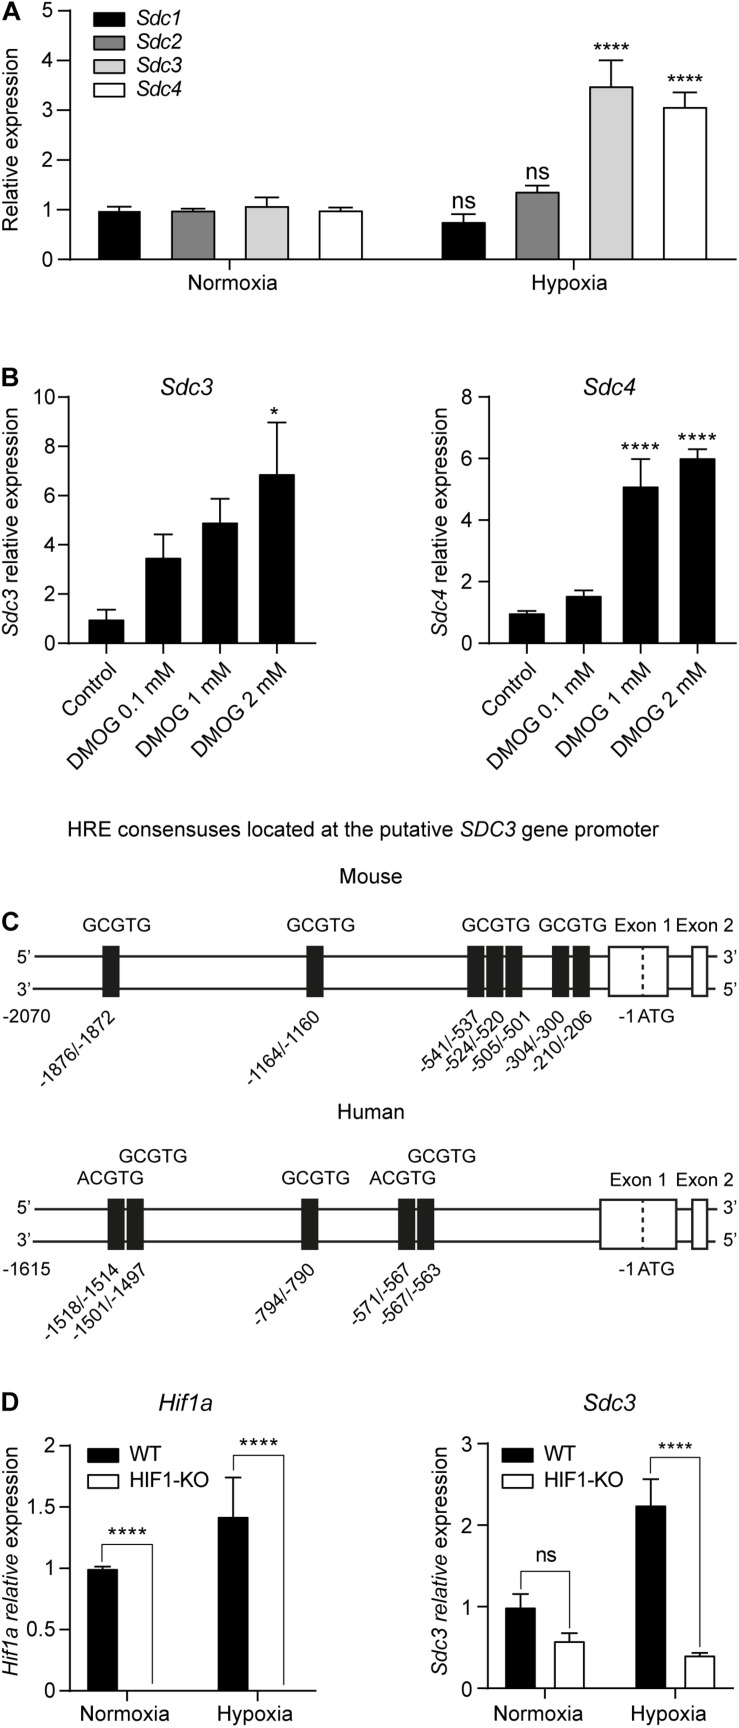
Hypoxia upregulates Sdc-3 expression on tumor cells on a HIF-1α dependent mechanism. (A) Expression of Sdc-1, Sdc-2, Sdc-3, and Sdc-4 on mouse tumor CT26 cells cultured under normoxia (21% oxygen) or hypoxia (1% oxygen) for 24 h. A pool of three independent experiments is shown, error bars represent SEM (unpaired T test). (B) Expression of Sdc-3 (left) and Sdc-4 (right) on CT26 cells treated with increasing doses of DMOG (0, 0.1, 1, and 2 mM) under normoxia for 48 h. One representative experiment is shown, error bars represent SD (one-way ANOVA test). (C) Schematic linear map of HREs (5′-RCGTG-3′, being R: A or G) in the predicted mouse (upper) and human (lower) putative promoter of Sdc-3. (D) Expression of Hif1a (left panel) and Sdc3 (right) genes on WT and HIF1-KO CT26 cells cultured under normoxia or hypoxia for 24 h. A pool of two independent experiments is shown, error bars represent SEM (two-way ANOVA test). Asterisks represent p values for each statistical test as follows: ns (p > 0.05), * (p ≤ 0.05), ** (p ≤ 0.01), *** (p ≤ 0.001), and **** (p ≤ 0.0001).